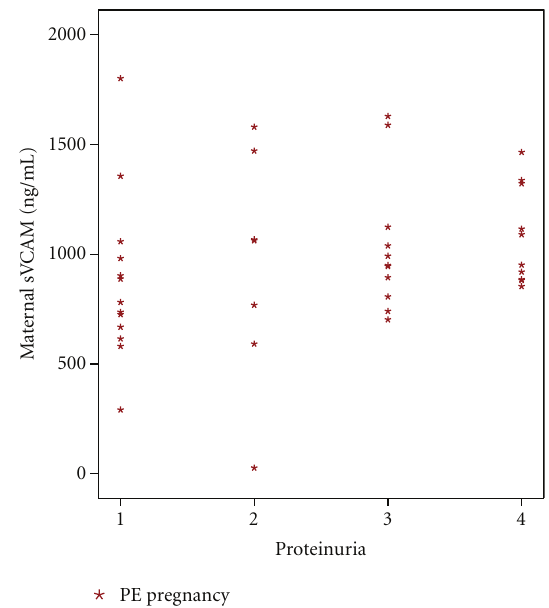
Figure 2: Correlation between maternal proteinuria and sVCAM, in PE (Spearman’s correlation coe ffi cient, 0.33; P = 0 . 027).